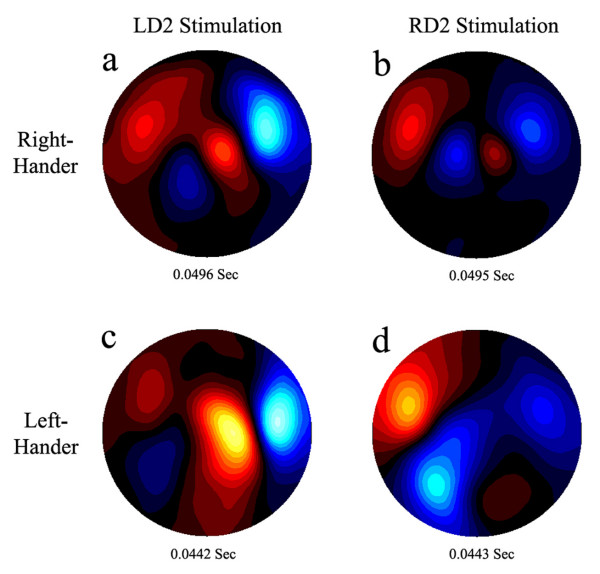
Two ipsilateral early responses examples. The top two averaged sensor data plots are from a right-handed subject, the bottom two are from a left-handed subject. Figures in the left column show the two subjects' sensor plots at the early ipsilateral (left hemisphere) response peak moment under the LD2 stimulation condition. The peak ipsilateral (left hemisphere) response is still weaker than the contralateral (right hemisphere) response, though the right hemisphere response is not at its peak at this time. Figures in the right column show similar results for RD2 stimulation. Both LD2 and RD2 stimulation elicited bilateral early responses in these two subjects.